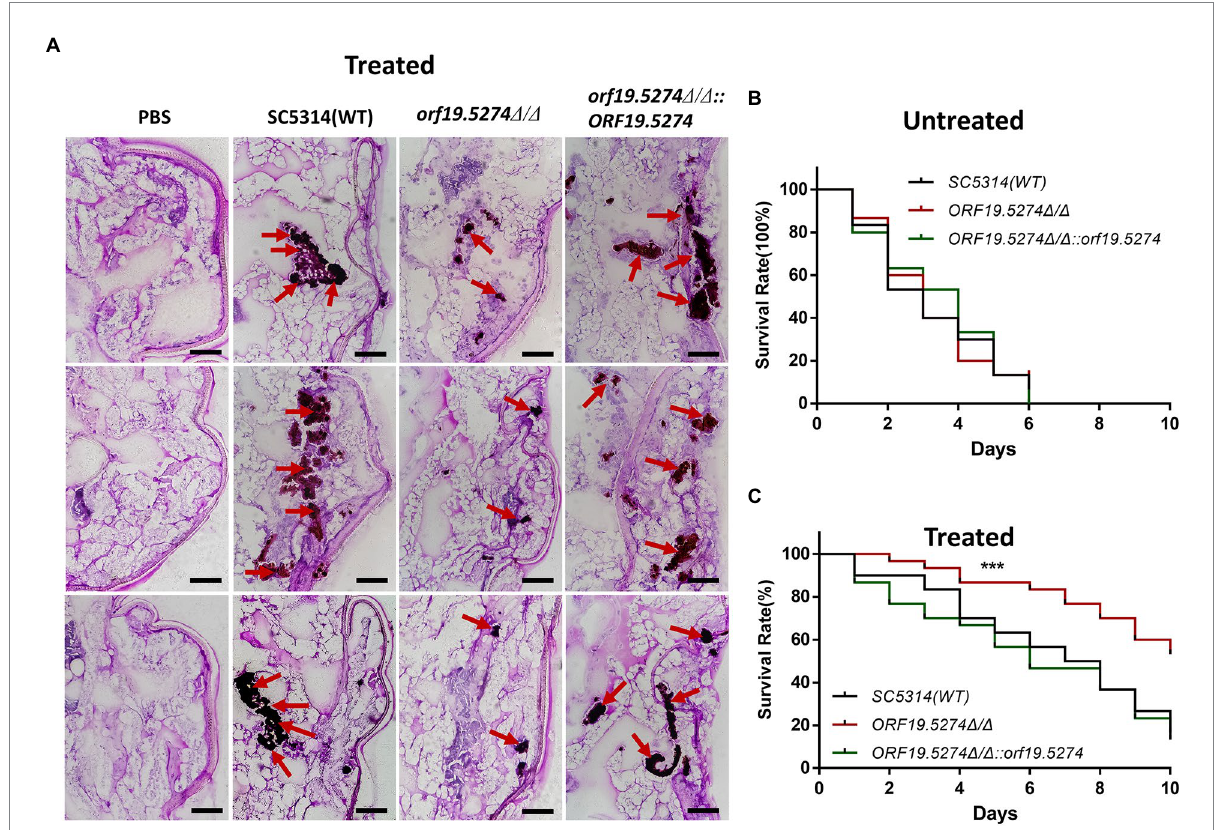
FIGURE 9 The virulence changes and efficacy of SC5314, orf19.5274 Δ / Δ , orf19.5274 Δ / Δ ::ORF19.5274 in larval infection model of G. mellonella . (A) PAS section staining of SC5314, orf19.5274 Δ / Δ , orf19.5274 Δ / Δ ::ORF19.5274 strains infected with G. mellonella larvae models treated with 64 g/ml FLC. Then, 10 μ l of 1 × 10 8 CFU/ml of fungal cells were injected into the left hind foot of the G. mellonella larvae, and the whole worms were taken for frozen sections after 24 h. The red arrows in the pictures show the fungal hypha-yeast mass after staining. (B) SC5314, orf19.5274 Δ / Δ , orf19.5274 Δ / Δ ::ORF19.5274 growth curves infected with G. mellonella larvae model for 10 days (Log-rank test). (C) Survival curves of G. mellonella larvae models infected with SC5314, orf19.5274 Δ / Δ , orf19.5274 Δ / Δ ::ORF19.5274 strains for 30 min after treatment with 64 μ g/ml FLC,